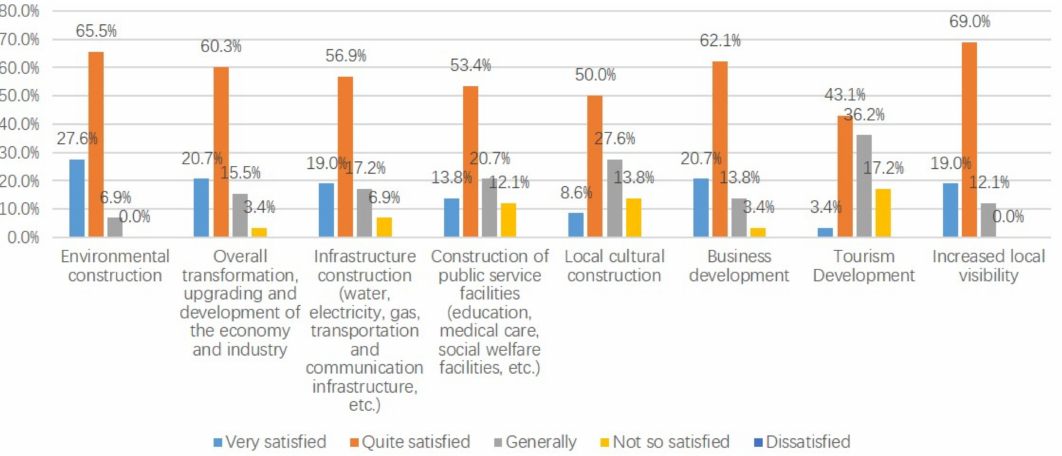
Figure 35. Respondents’ satisfaction with the local CT practice to promote local development (YDT) (source: authors).